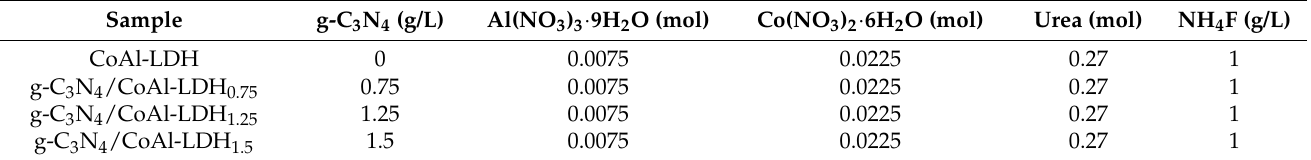
Table 3. Proportion of the CoAl-LDH and the g-C3N4/CoAl-LDH nanocomposites.